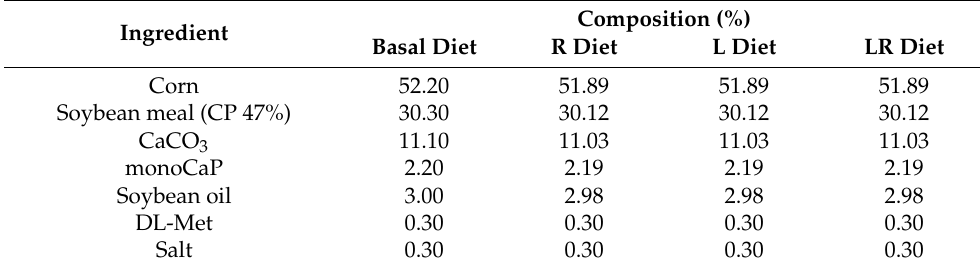
Table 2. Compositions of basal and experimental